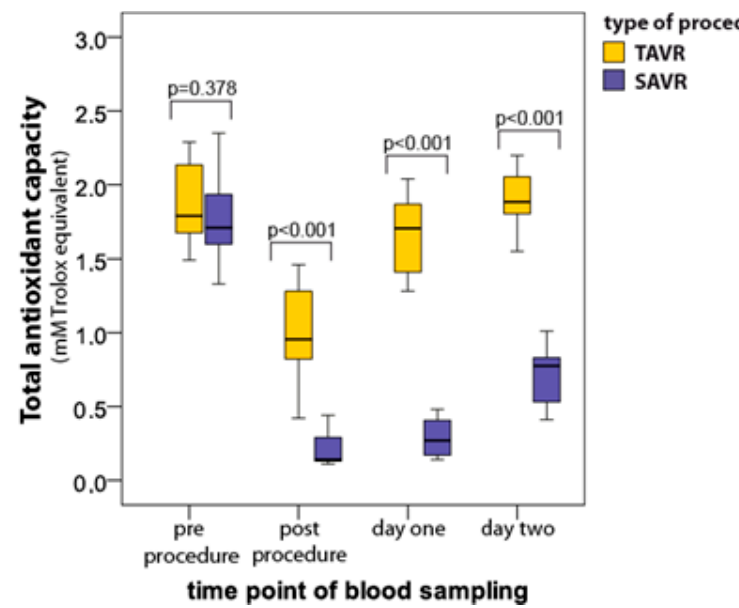
Figure 1. Serum total antioxidant capacity (median with interquartile range) in patients undergoing percutaneous aortic valve implantation (TAVR) ( n = 12) and surgical aortic valve replacement (SAVR) ( n = 12) procedures.